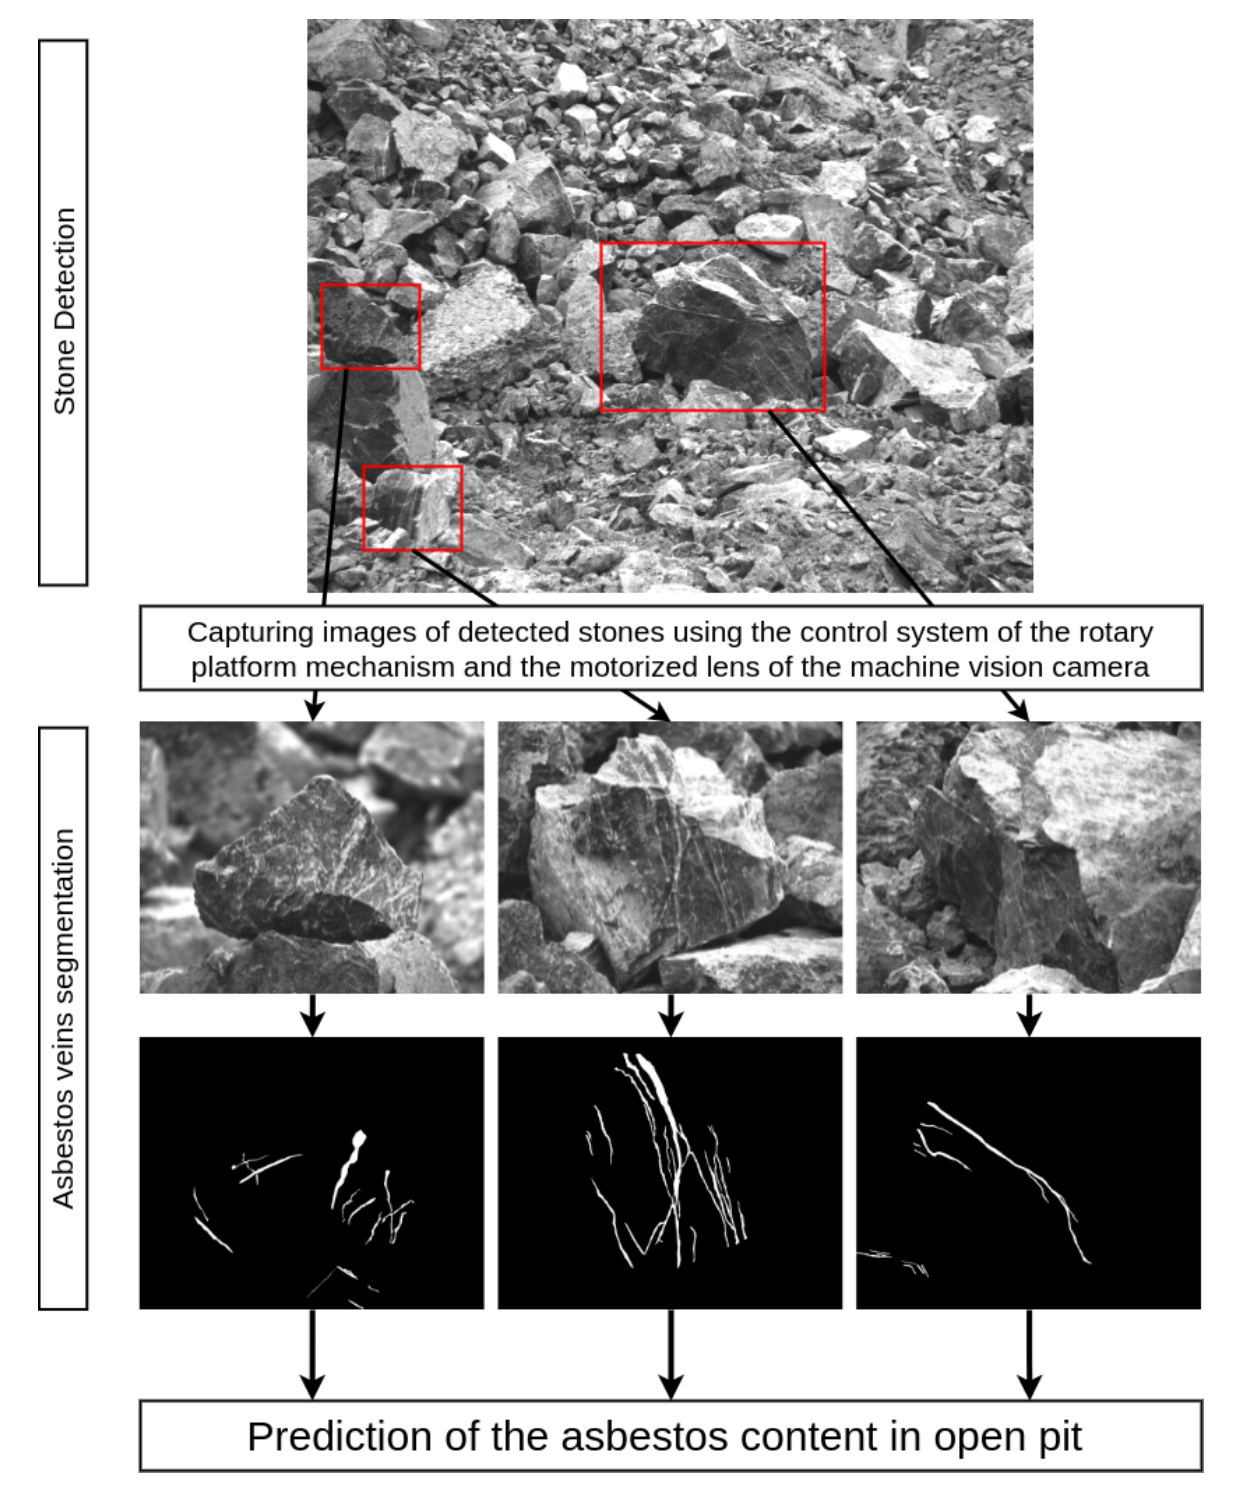
Figure 3. The scheme of the asbestos productivity estimation in the open